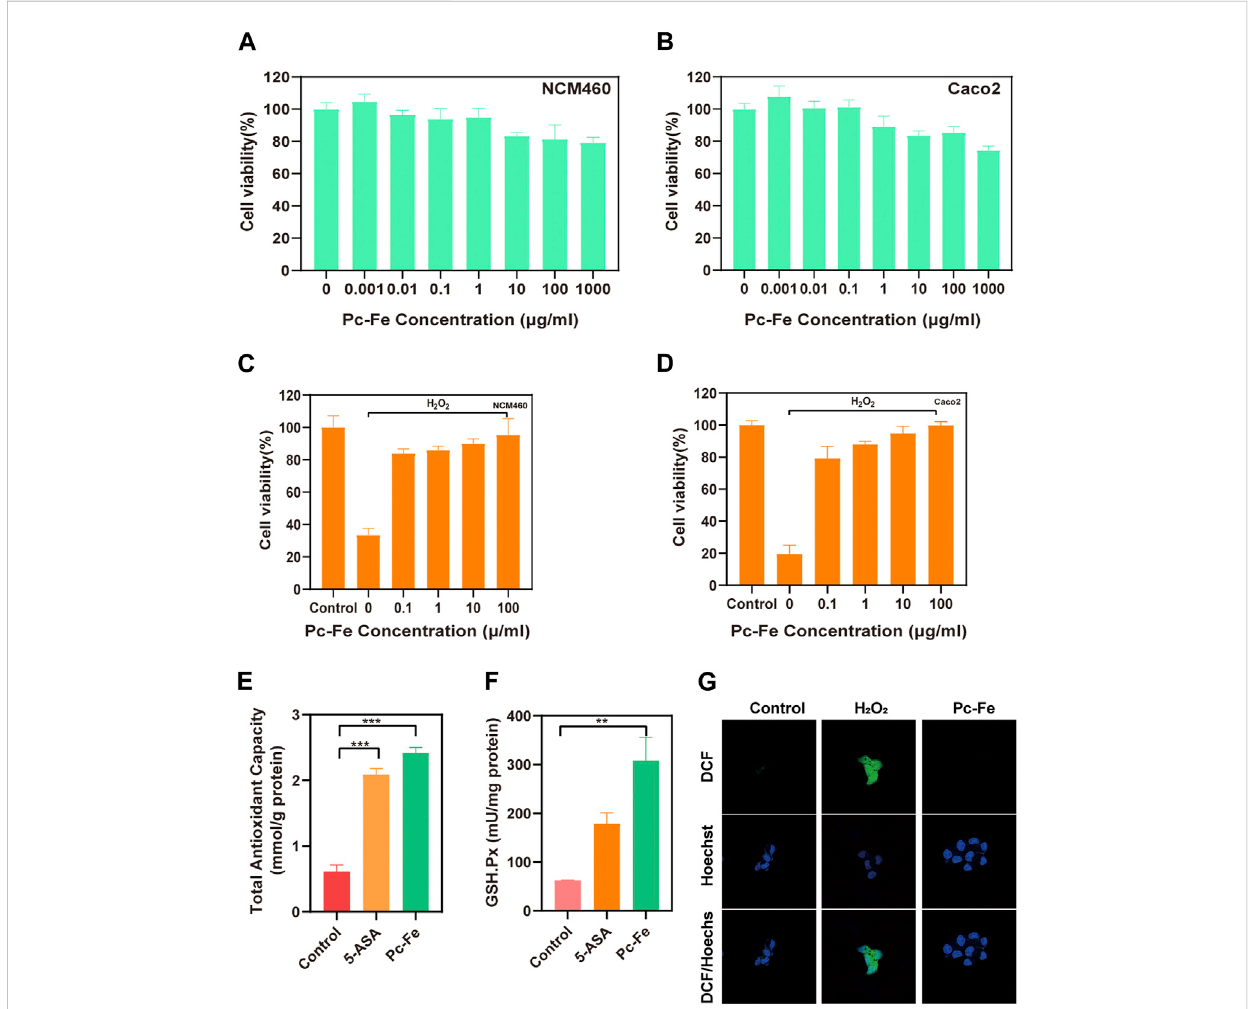
FIGURE 4 Cell safety evaluation and antioxidant activity of Pc-Fe. (A,B) Cell viability of NCM460 and Caco2 cells after Pc-Fe incubation. (C,D) Cell viability of NCM460 and